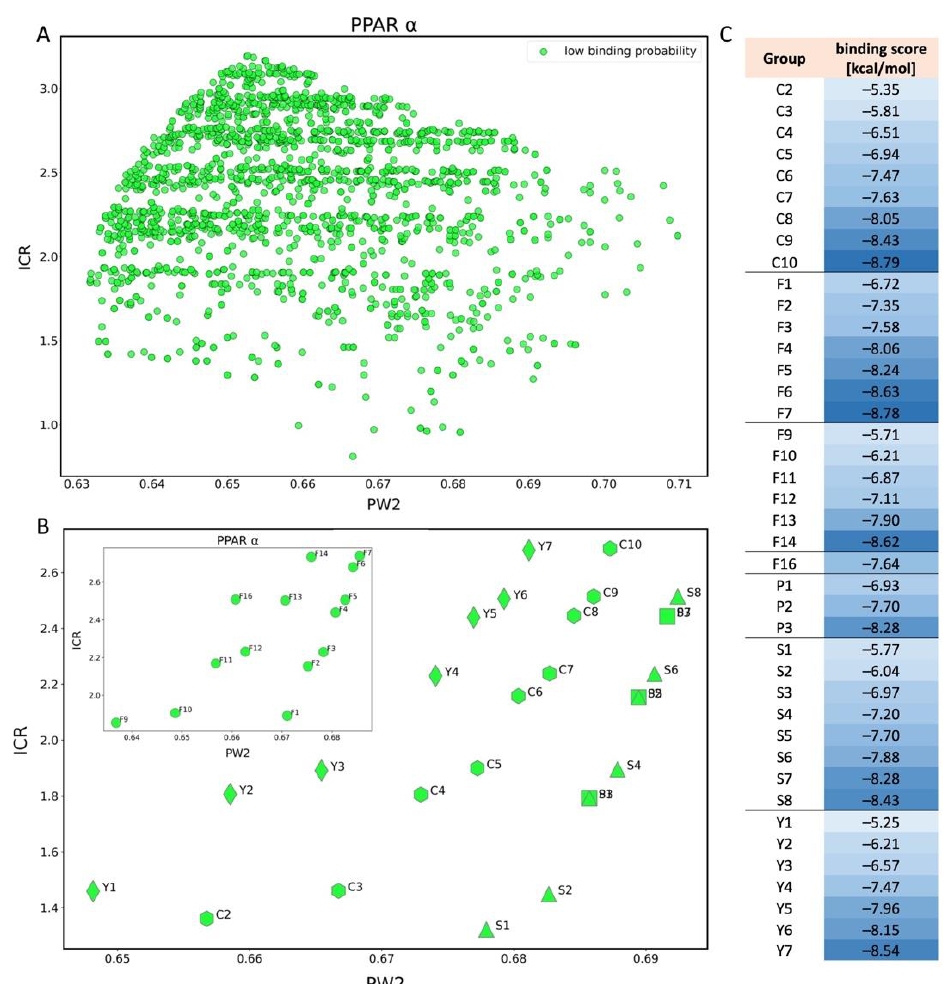
Figure 4. ( A ) Scatter plot of binding scores obtained for PPAR α in PW2 and ICR space; ( B ) scatter plot for PPAR α showing the division of PFAS into five different structural groups in space of PW2 and ICR. C-carboxylic acids (COOH-(CF2)n-CF3), S-sulfonic acids (SO3H-(CF2)n-CF3), P-phosphonic acids (PO3H2-(CF2)n-CF3, F-Fluorotelomer alcohol (F1-F7(OH-(CH2)-(CF2)n-CF3), F8-F14 (OH-(CH2)2-(CF2)n-CF3), F16 (OH-(CH2)3-(CF2)n-CF3), F17 (OH-(CH2)4-(CF2)n-CF3)), Y-dicarboxylic acids (COOH-(CF2)n-COOH). Colors: green-low binding probability; ( C ) Table showing binding score values for each compound shown in chart B.